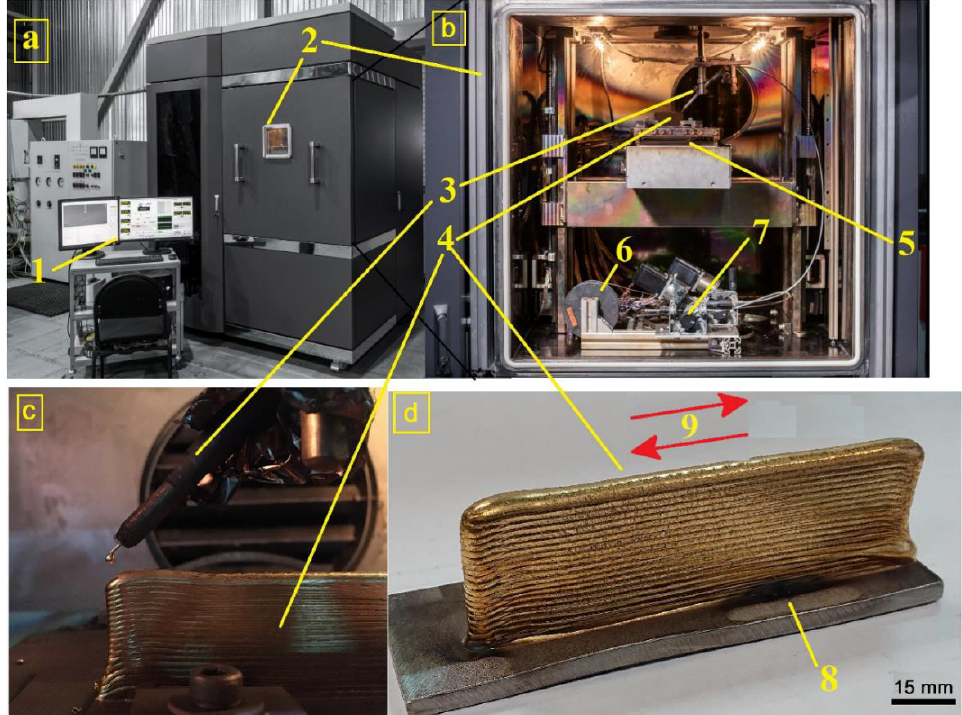
Figure 1. Electron beam wire-feed additive machine ( a – c ) and a Cu-7.5wt.%Al wall built ( d ). 1—control panel; 2—vacuum chamber; 3—wire guide; 4—sample printed; 5—water-cooled table; 6—wire reel; 7—wire feeder; 8—stainless steel substrate; 9—layer-by-layer deposition strategy.